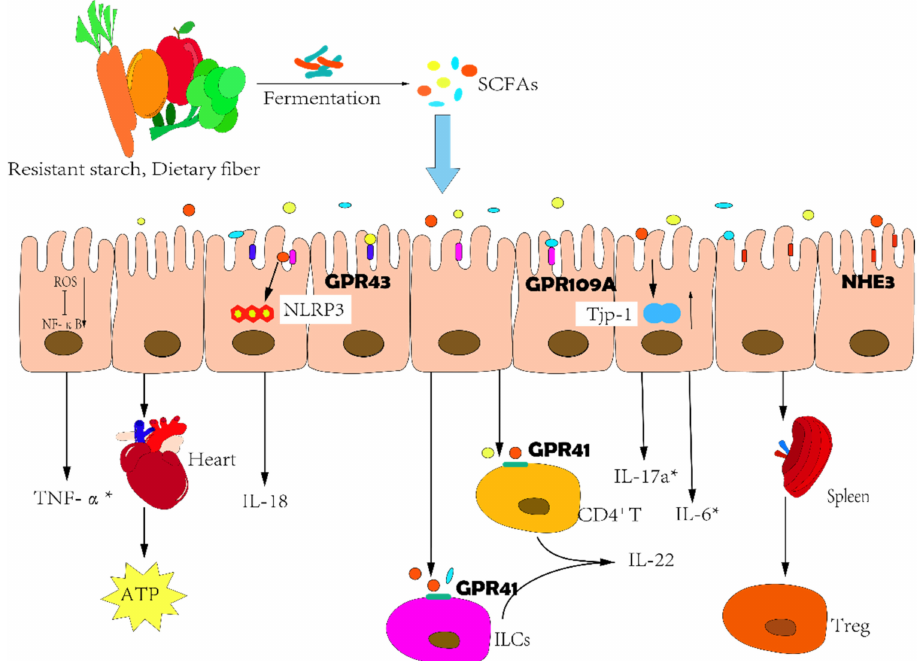
Figure 2. Correlation between SCFAs and heart failure. Short-chain fatty acids (SCFAs) inhibit intestinal and systemic inflammation by binding to G-protein receptor 43 (GPR43), G-protein receptor 109A (GPR109A) and G-protein receptor 41 (GPR41) on the surface of a variety of cells. The secretion of pro-inflammatory factors decreased while anti-inflammatory factors such as IL-22 increased. Moreover, the nuclear transcription factor kappa-B (NF- κ B) signaling pathway and immune cells are also involved in the anti-inflammatory process of SCFAs. Apart from this, SCFAs can also enhance myocardial energy metabolism, maintain metabolic homeostasis, and play a cardioprotective role. * denotes decrease; SCFAs, short-chain fatty acids; GPR43, G-protein receptor 43; GPR109A, G-protein receptor 109A; GPR41, G-protein receptor 41; NHE3, sodium–hydrogen exchanger-3; ROS, reactive oxygen species; NF- κ B, nuclear transcription factor kappa-B; NRP3, NLRP3 inflammasome; Tjp-1, tight-junction protein-1; TNF- α , tumor necrosis factor- α ; IL-18, interleukin-18; IL-17a, interleukin-17a; IL-6, interleukin-6; IL-22, interleukin-22; ILCs, innate lymphoid cells; Treg, regulatory T cell; ATP, adenosine